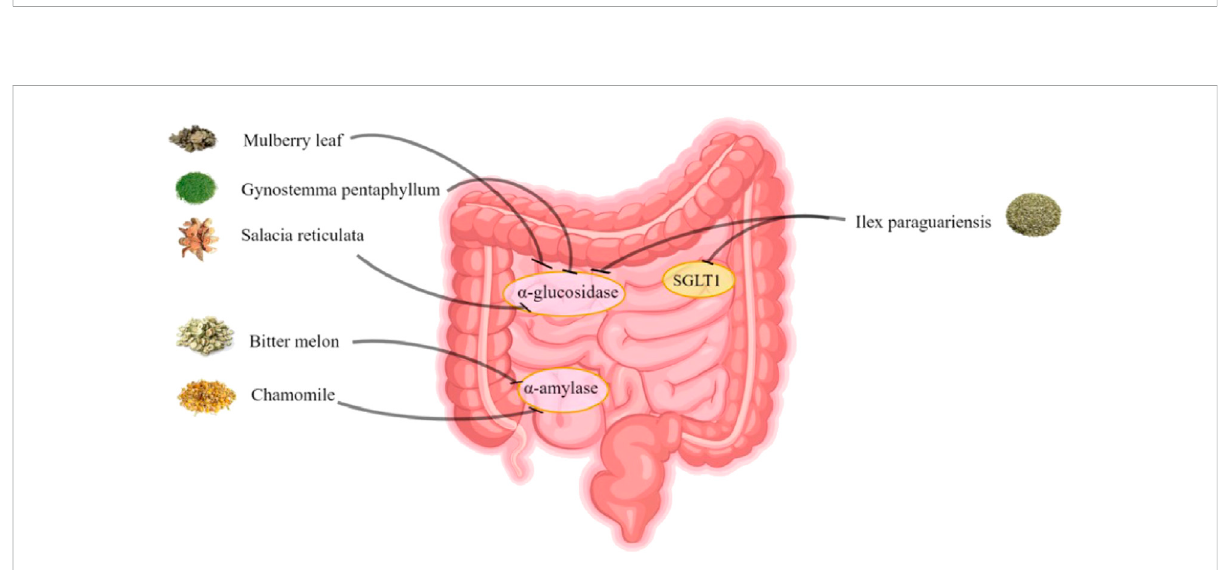
FIGURE 4 Inhibitory effect of herbal teas on glucose